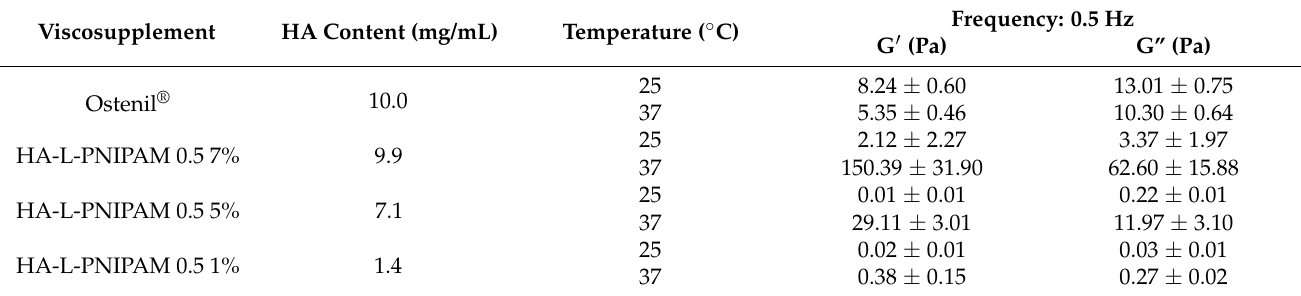
Table 1. Summary of viscoelastic properties obtained in rheology for Ostenil ® and different HA-L- PNIPAM 0.5 concentrations at 25 ◦ C and 37 ◦ C. HA contents for Ostenil ® were calculated according to values obtained in 1 H NMR